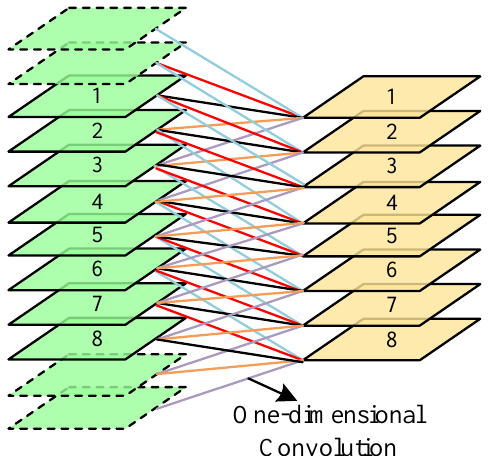
Figure 9. Process diagram before and after one-dimensional convolution operation ( K =